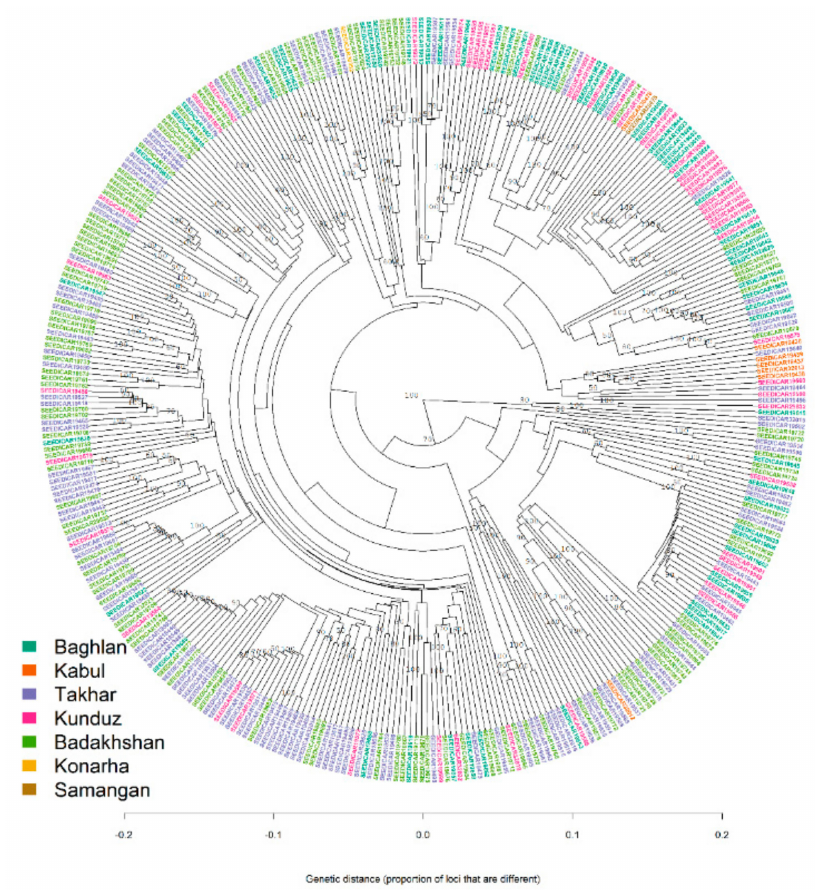
Figure 6. Neighbour-joining clustering of 363 Afghan bread wheat landraces.